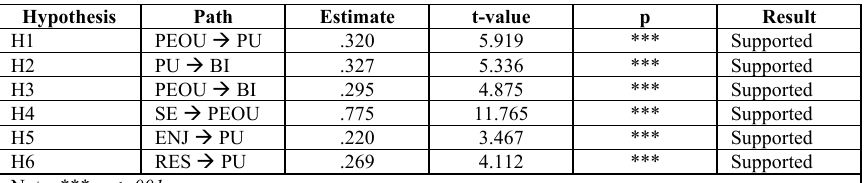
Table 4. Standardized path